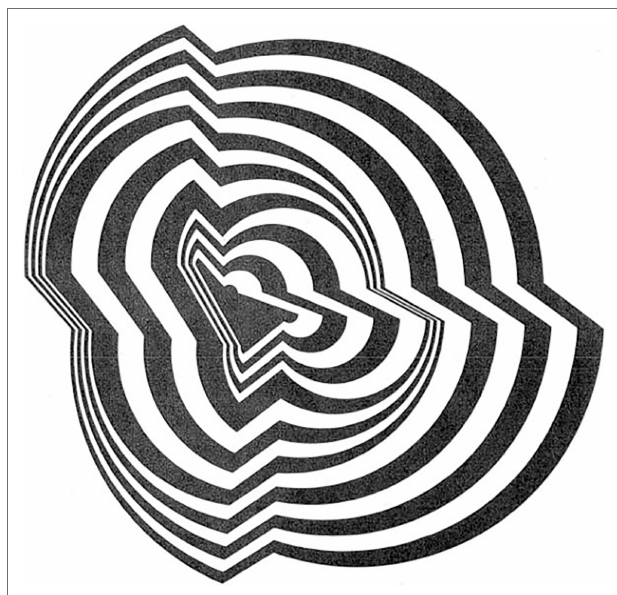
FIGURE 6 | Disfigured Circle by Bridget Riley depicts depth from aligned angles (Shapley and Maertens, 2008). © Bridget Riley. Reproduced with